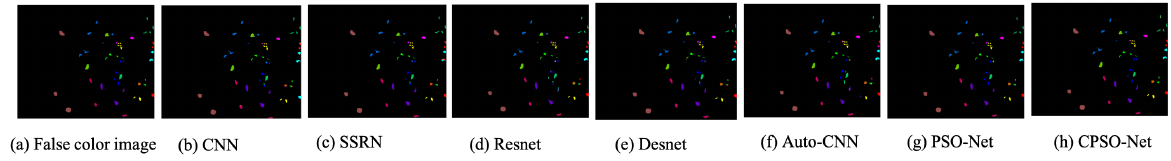
Figure 14. Classification maps based on the biased Indian Pines dataset.